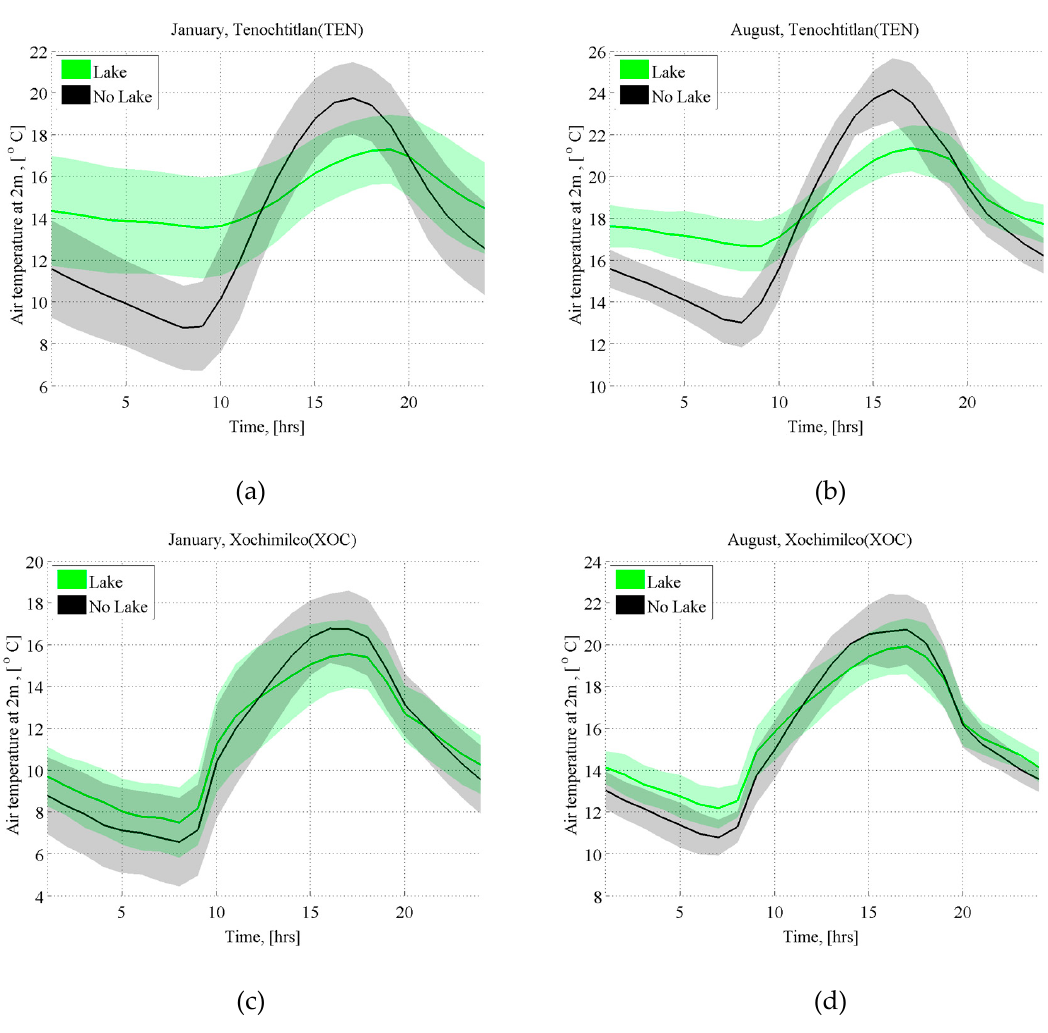
Figure 7. Mean hourly air temperature at 2 m above the surface at Tenochtitl á n in January ( a ) and